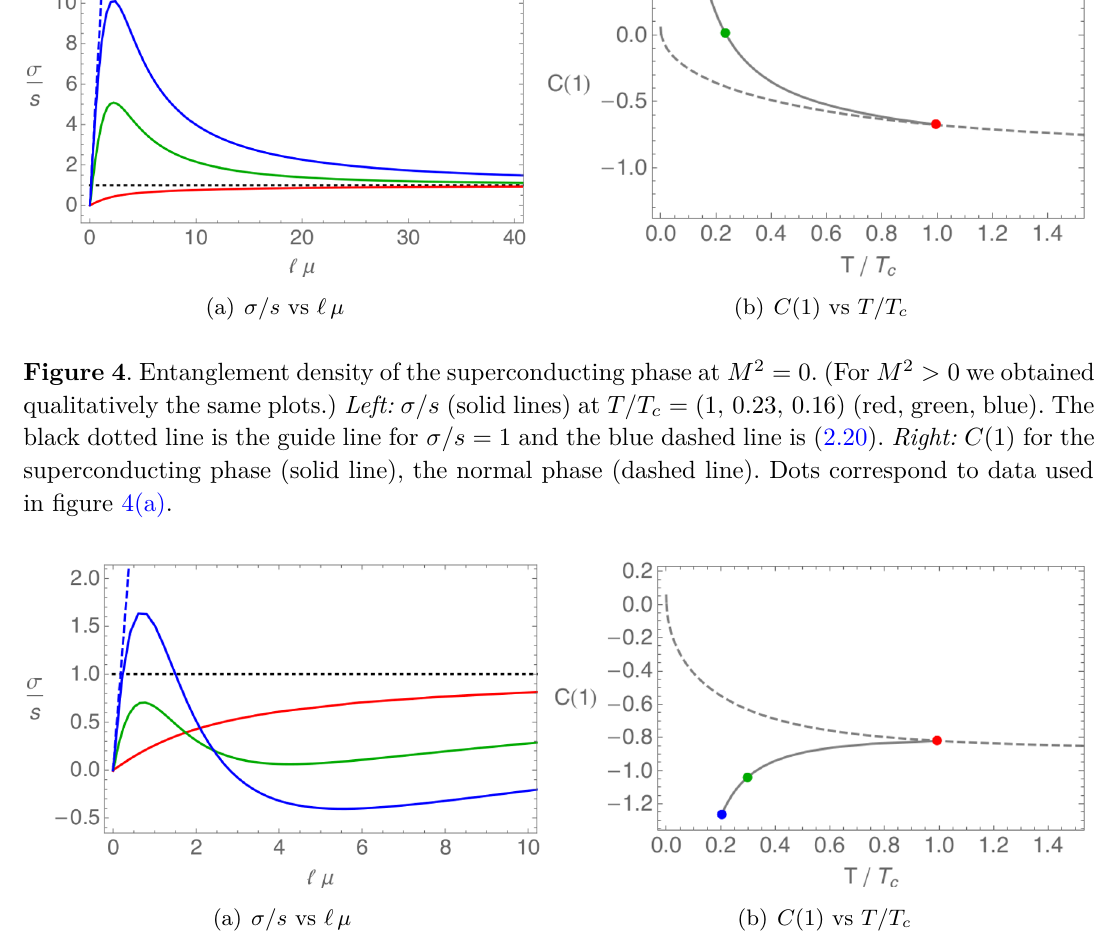
Figure 5 . Entanglement density of the superconducting phase at M 2 = − 2 . Left: σ/s (solid lines) at T/T c = (1 , 0 . 3 , 0 . 2) (red, green, blue). The black dotted line is the guide line for σ/s = 1 and the blue dashed line is (2.20). Right: C (1) for the superconducting phase (solid line), the normal phase (dashed line). Dots correspond to data used in figure